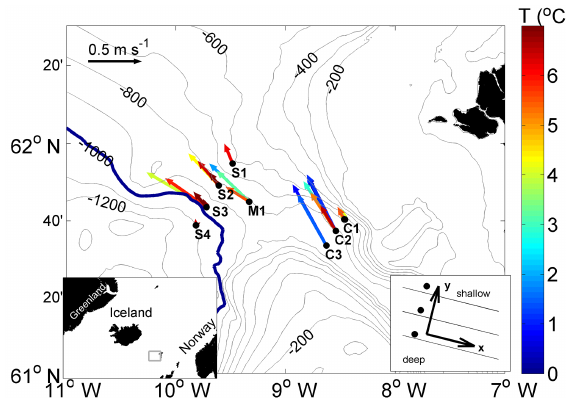
Figure 1. Map of the study region with the mooring positions (black dots) and mean current vectors from selected levels (75, 100, 150, 200, 250, and 300m above the seabed) at each site, colour-coded by mean temperature from the same depth level (colour scale in ◦ C on the right). Depth contours in grey are shown every 100m with the 1000m isobath bold, black. Insets show (left) the location of the study area and (right) the orientation of the coordinate system with respect to the mooring